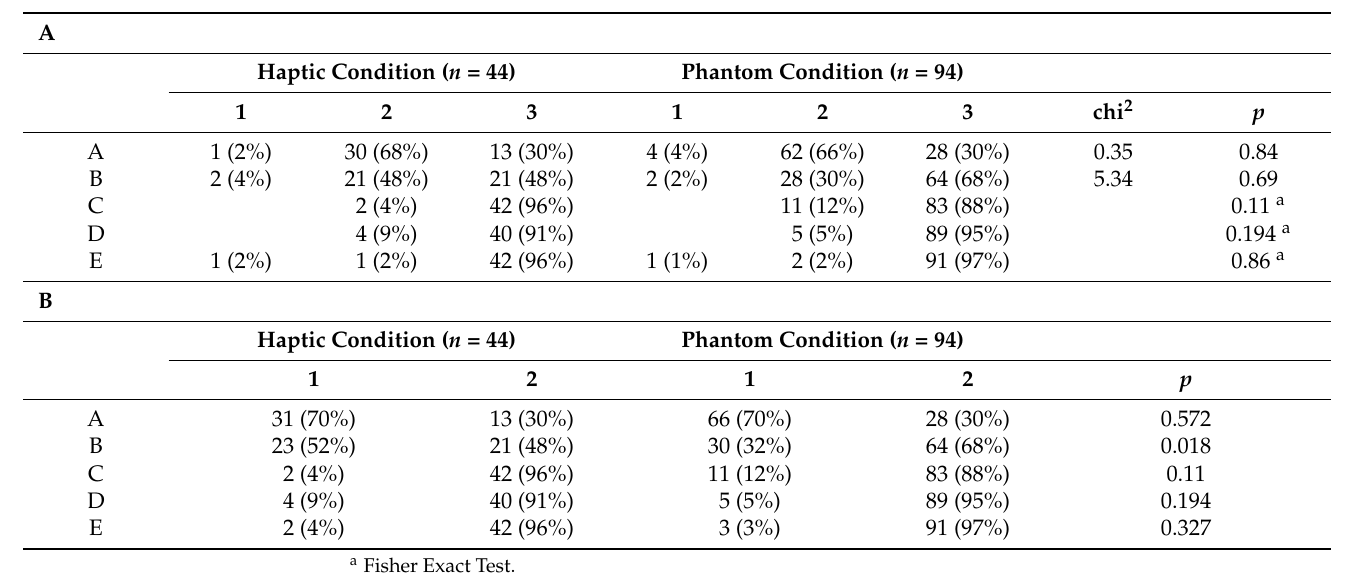
Table 3. A: Comparison of performance on individual criteria ( n = 139, Study 1). B: Re-coded comparison of performance on individual criteria ( n = 139, Study 1).